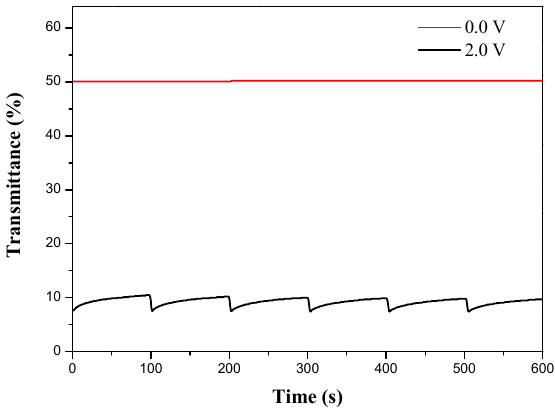
Figure 10. Open circuit stability of the P(BCz- co -ProDOT)/triple-layer PEDOT-PSS device monitored at 642 nm.